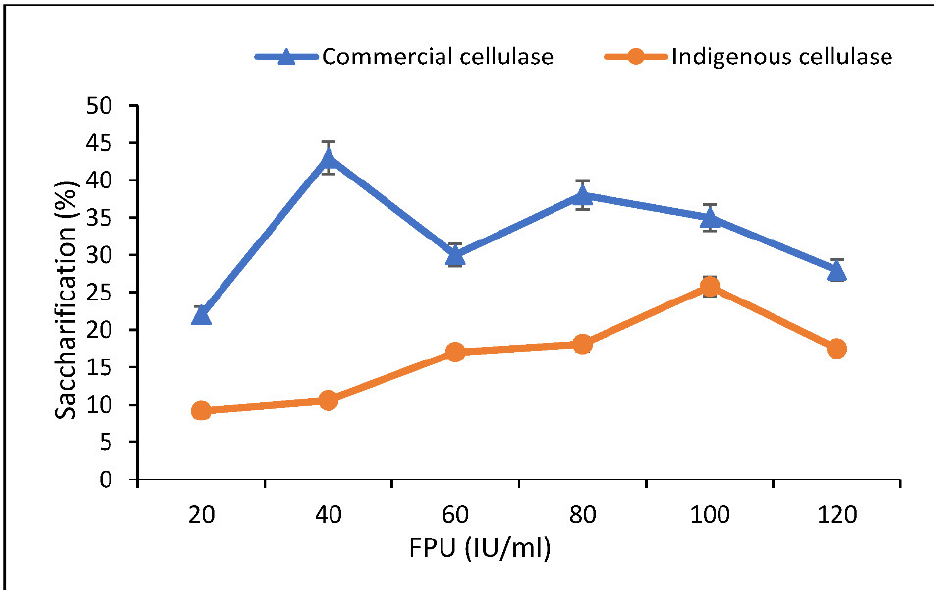
Figure 7. Optimization of enzyme concentration (IU/mL) for saccharification.